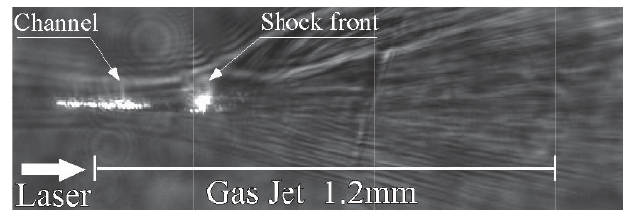
FIG. 2. Plasma shadowgraph image. The channel in the pre- plasma is produced by the laser